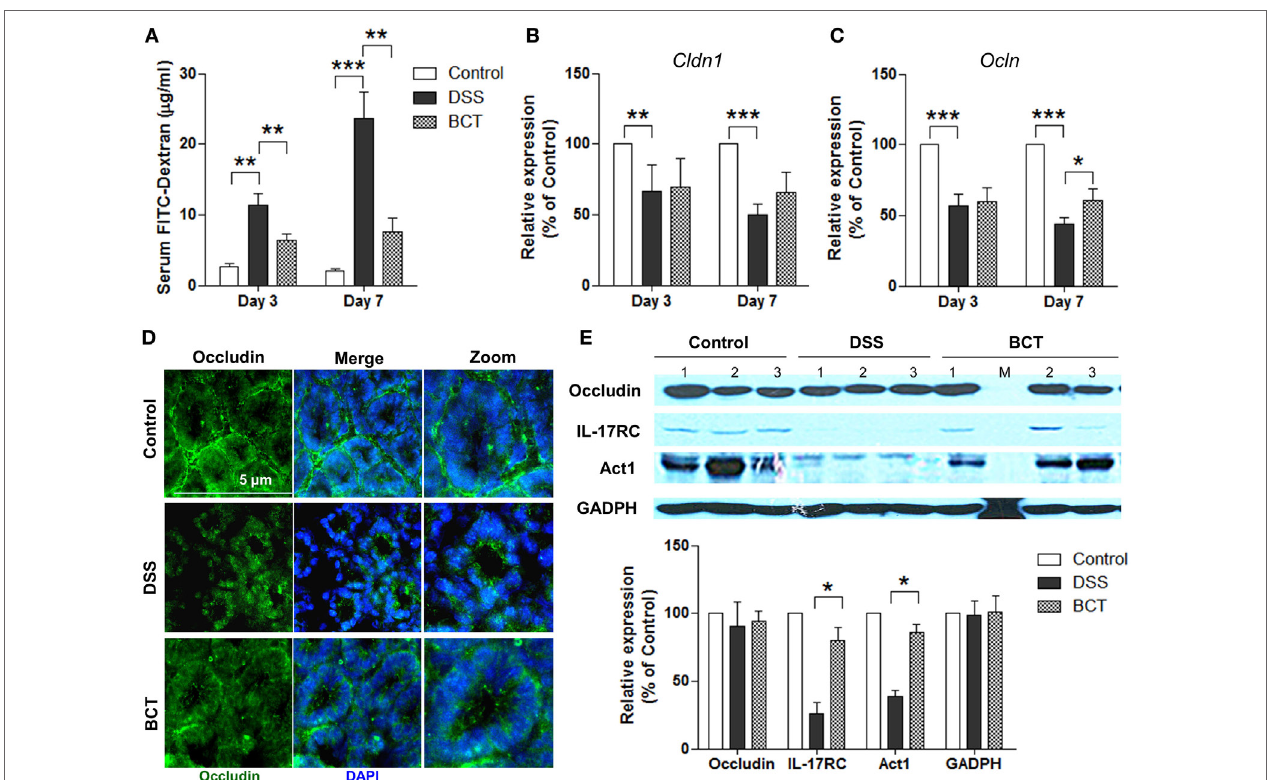
FigUre 2 | BCT enhanced intestinal barrier function of colitis mice by regulating IL-17-Act1-occludin axis. (a) Detection of FITC-dextran in serum of mice by ELISA. (B,c) The relative expressions of genes encoding claudin and occludin proteins in colon tissues of mice detected by qPCR. (D) Representative immunofluorescence images of occluding (green) and DNA (blue) of distal colon segments from mice of different groups. The third column represents a magnified image. (e) The expression of occludin, IL-17RC, and Act1 detected by Western blot with GADPH as internal control. All values are mean ± SEM ( n = 5). Statistical analysis of the quantitative multiple group comparisons was performed using the one-way analysis of variance followed by Tukey’s test, * p < 0.05, ** p < 0.01, *** p <